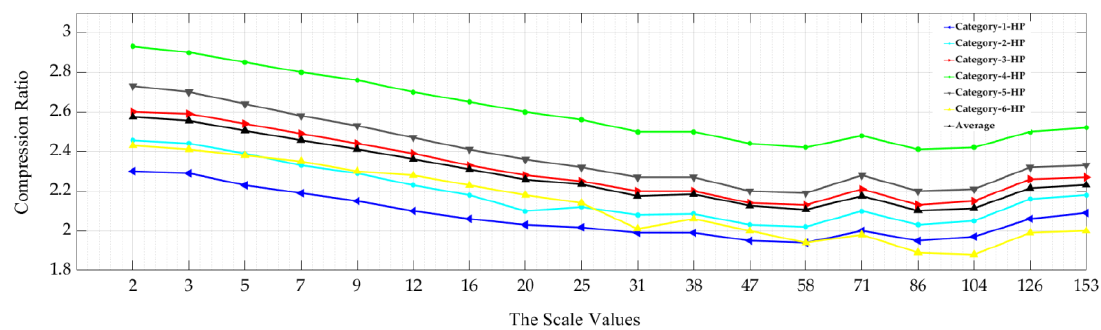
Figure 16. Relationship between the scale of analysis and the six surface categories’ compression performance by using the multiscale band-pass (BP) data sets. Figure 17. Relationship between the scale of analysis and the six surface categories compression performance by using the multiscale high-pass (HP) data sets.